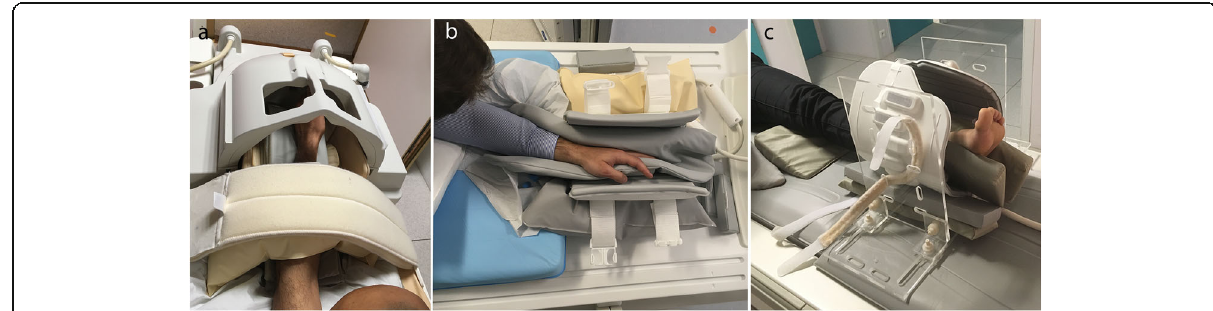
Fig. 7 Patient and coil positioning for wrist ( a ), finger ( b ), and ankle motion evaluation ( c ). The wrist is positioned within a head coil in an Achieva dStream 3.0 T Philips MRI scanner ( a ). The hand is positioned within an extremity coil (which is opened to show positioning inside) for